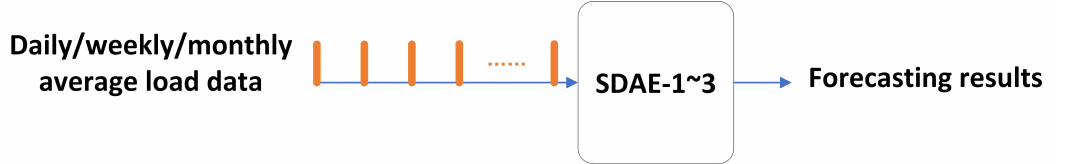
Figure 6. The framework of SDAE-1˜3.